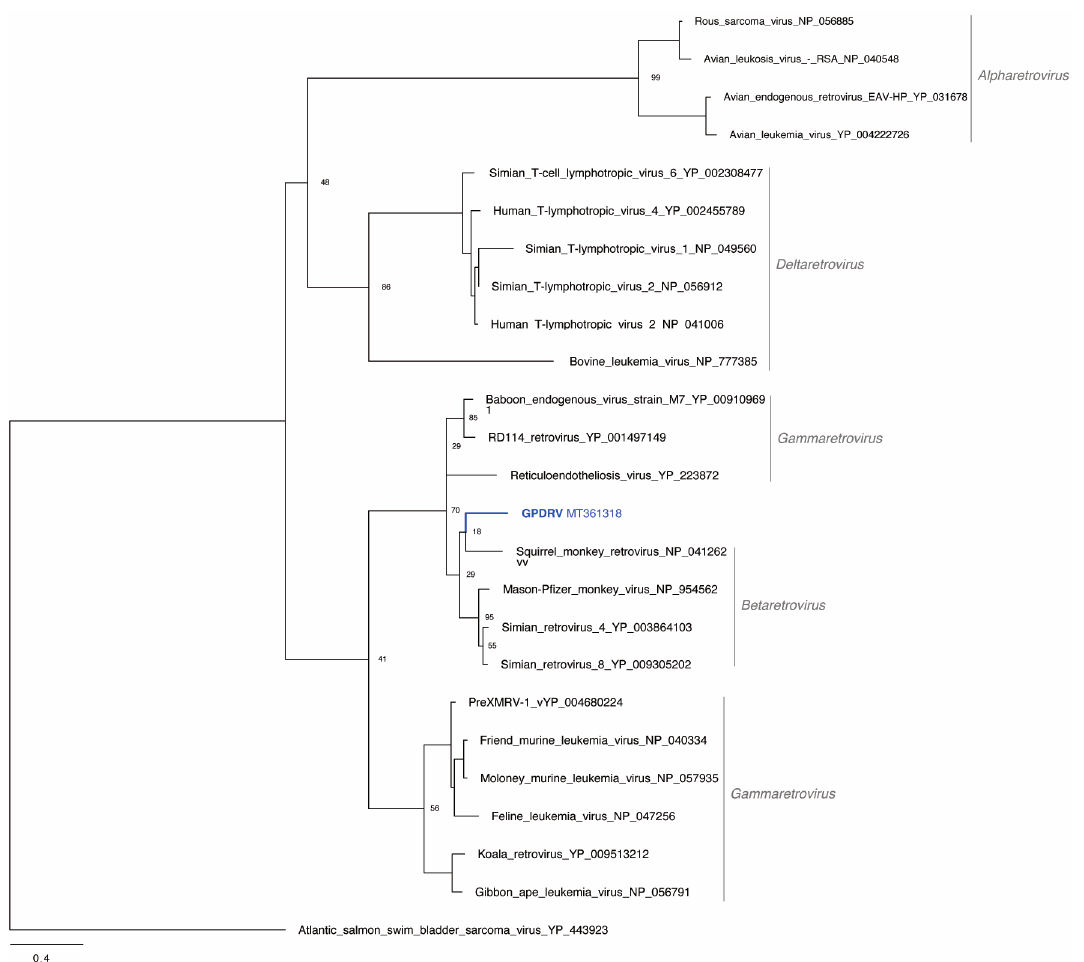
Figure 7. GPDRV Env transmembrane protein (TM) clusters with gamma and betaretrovirus sequences. All ENV TM sequences in the NCBI RefSeq protein database annotated as belonging to the Retroviridae family were used to infer a maximum-likelihood tree. The Felsenstein bootstrap (FBP) support values of select branches are indicated. Retrovirus genera are indicated. The tree is unrooted and was arbitrary midpoint rooted.